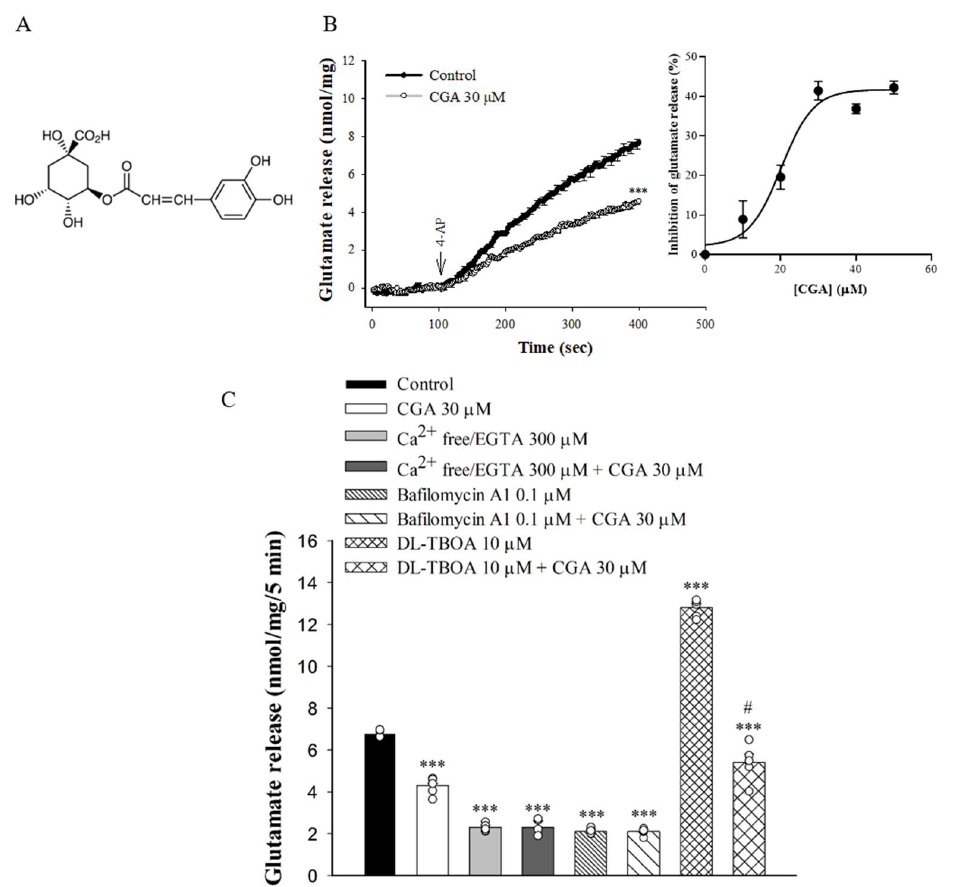
Figure 1. Effect of CGA on 4-AP-evoked glutamate release from rat cerebrocortical synaptosomes. ( A ) The chemical structure of CGA. ( B ) 4-AP-evoked glutamate release from synaptosomes incubated in the presence of 1.2 mM CaCl 2 and in the absence (control) or presence of CGA. Inset, dose– response curve for CGA inhibition of 4-AP-evoked glutamate release, showing percentage inhibition compared with controls. ( C ) Extracellular Ca 2+ -free solution containing EGTA, glutamate transporter inhibitor DL-TBOA or vacuolar H + ATPase inhibitor bafilomycin A1 on the action of CGA. CGA was added 10 min before the addition of 4-AP, and other drugs were added 10 min before this. Data are the mean ± SEM ( n = 5 per group). ***, p < 0.001 vs. control group. #, p < 0.05 vs. DL-TBOA- treated group.